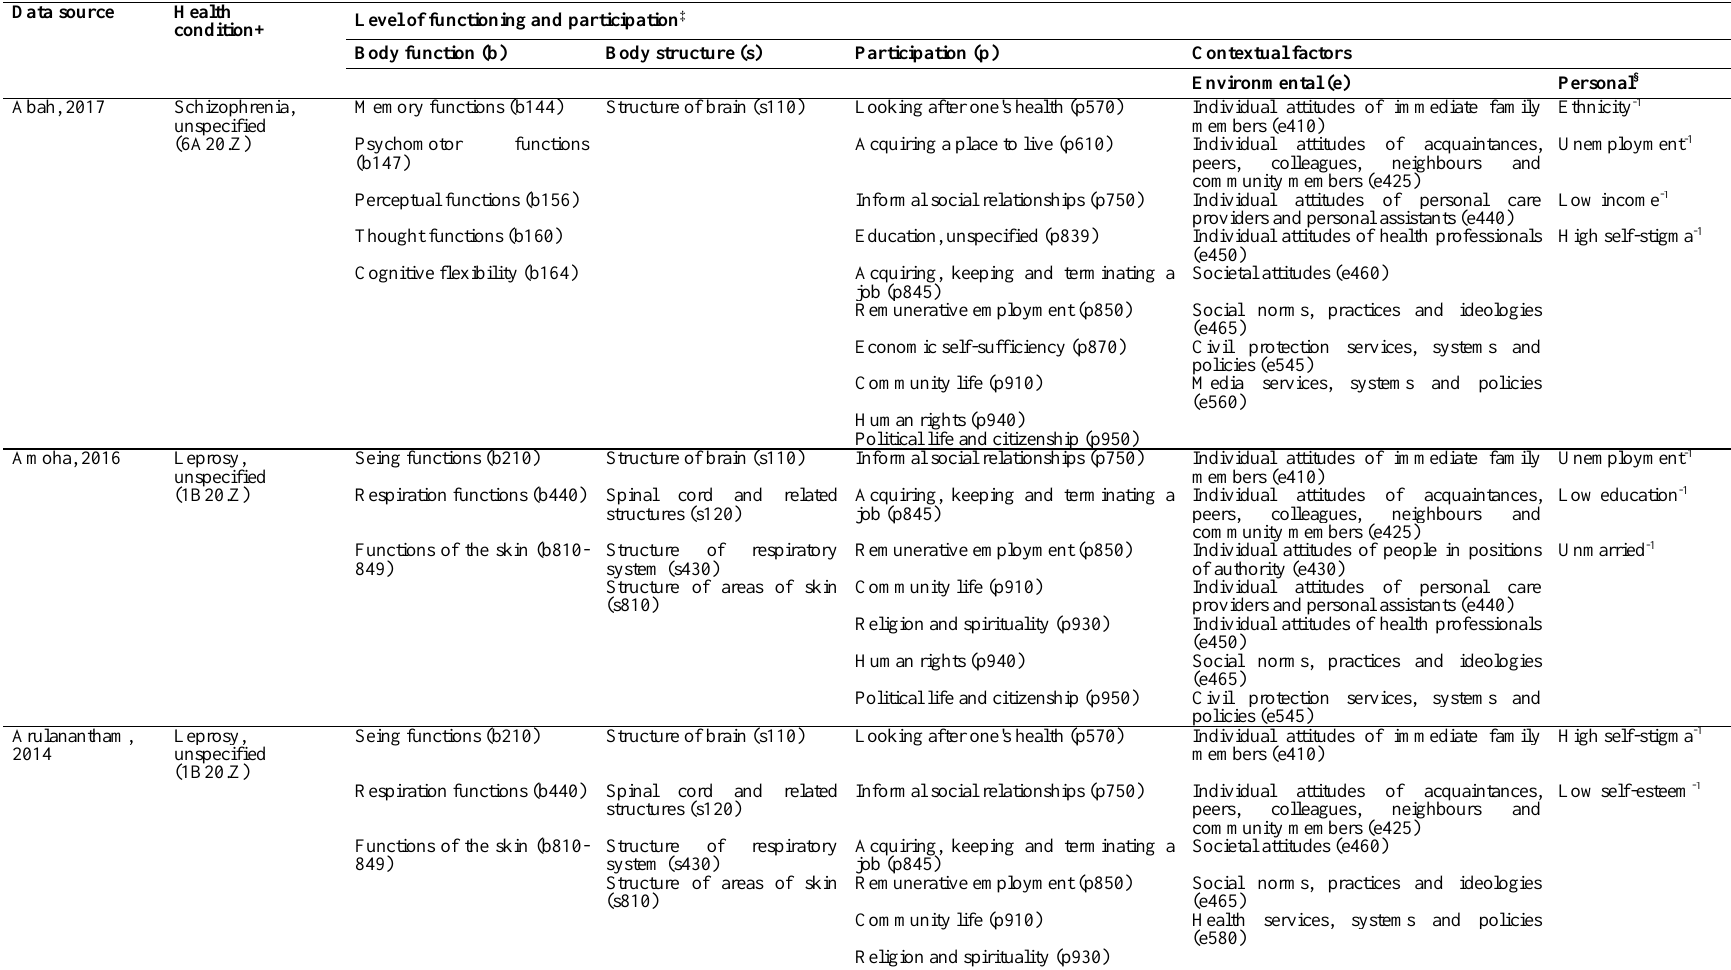
Table 1 – A1: Data coding and disaggregation, based on ICD-11 and ICF, to identify participation barriers in the literature. Data